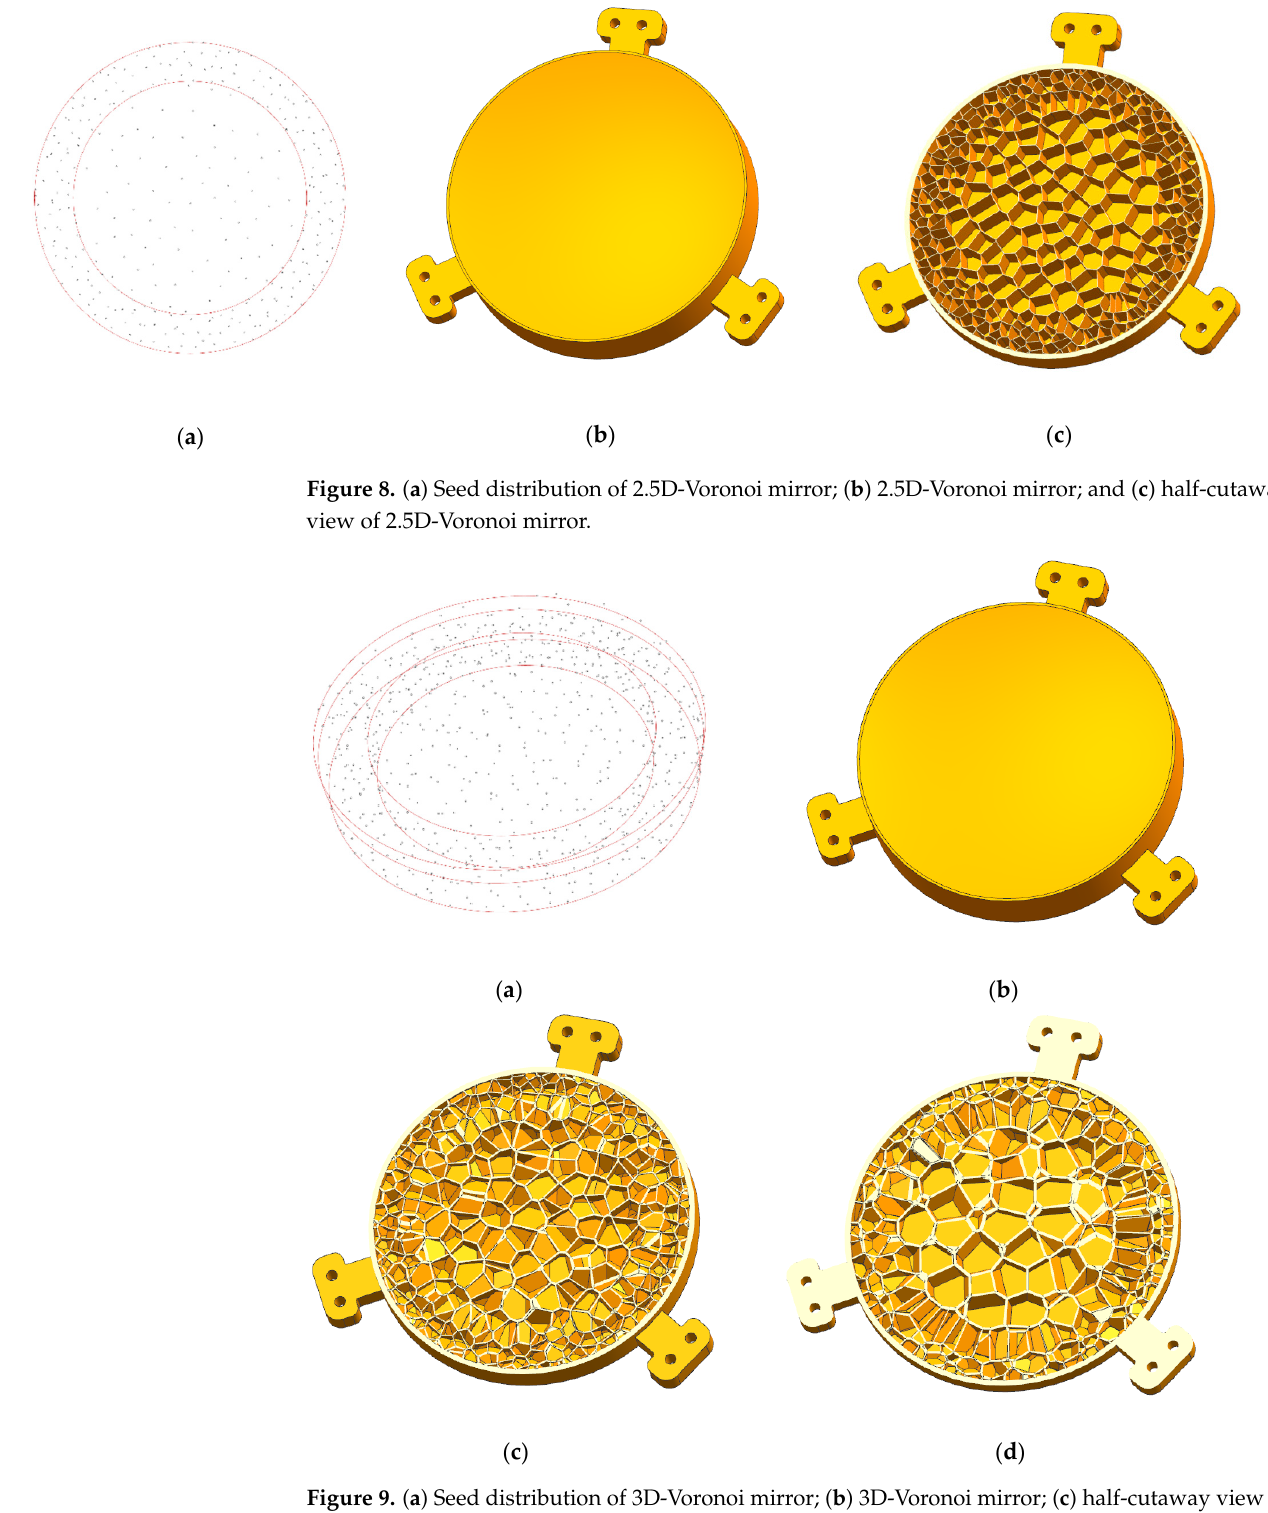
Figure 9. ( a ) Seed distribution of 3D-Voronoi mirror; ( b ) 3D-Voronoi mirror; ( c ) half-cutaway view of 3D-Voronoi mirror; and ( d ) 70%-cutaway view of 3D-Voronoi